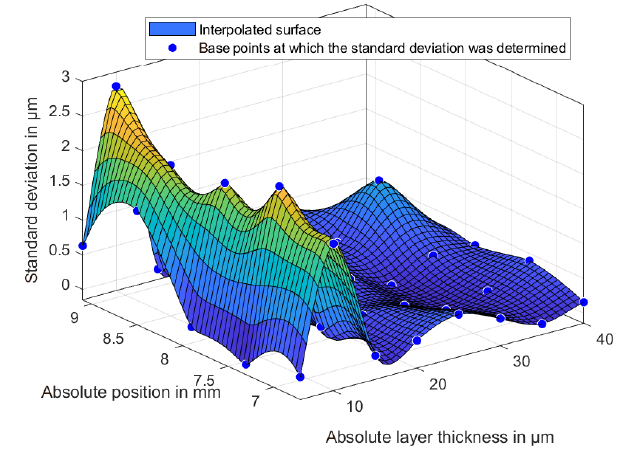
Figure 17. Standard deviation at 30 ◦ C and a test repetition of n = 20.